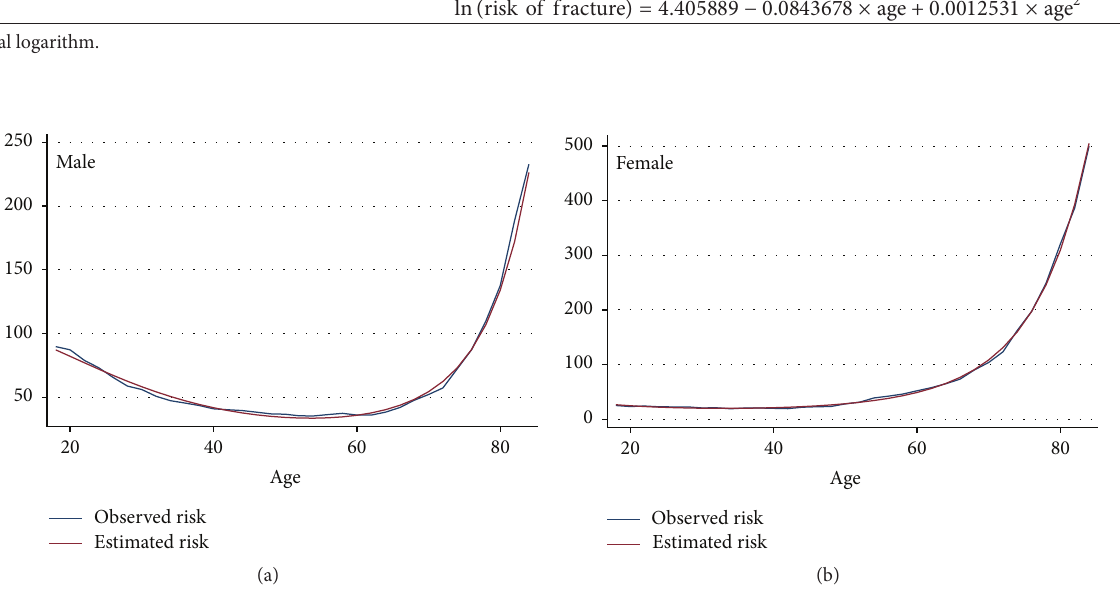
Figure 4: Comparison between observed gender-age-specific incidence rates of fracture hospitalisation and estimates from log-linear model (per 10,000